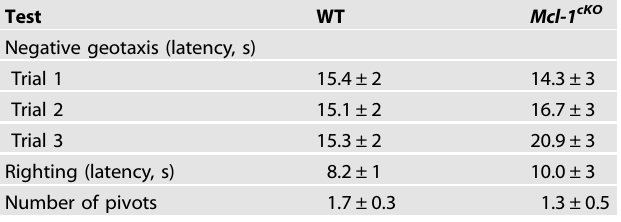
Table 1. No genotype-speci fi c effects seen in the neonatal behavioral